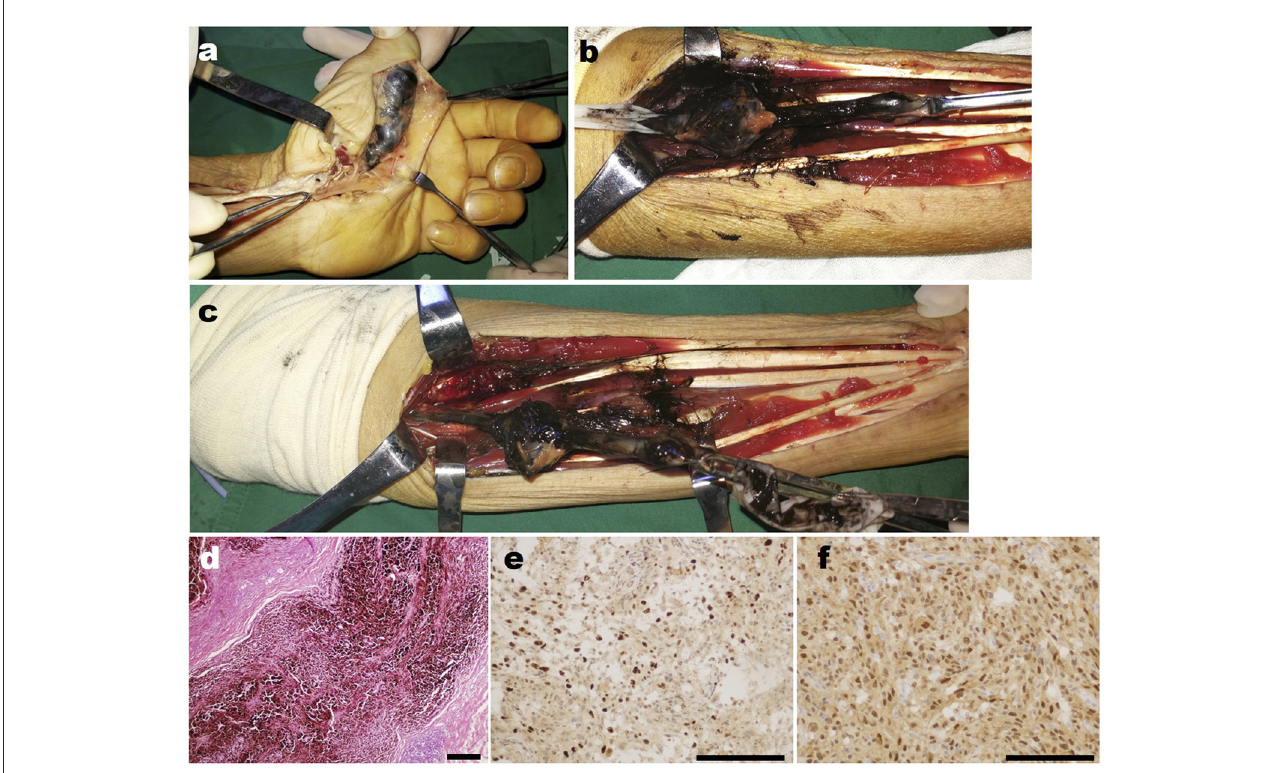
FIGURE1 Intra-operative findings of the patient’s first operation in our hospital. (a) The intraoperative photograph of the mass in the left hand of the patient. (b) The close-up detailed photograph of the mass in the left forearm shows the petroleum-like exudate. (c) The overall photographs of the mass in the left forearm of the patient. (d) The representative HE staining image of the resected tumor. (e) The representative Ki67 immunohistochemical staining image of the resected tumor. (f) The representative S100 immunohistochemical staining image of the resected tumor. Scar bar, 100 µ m.